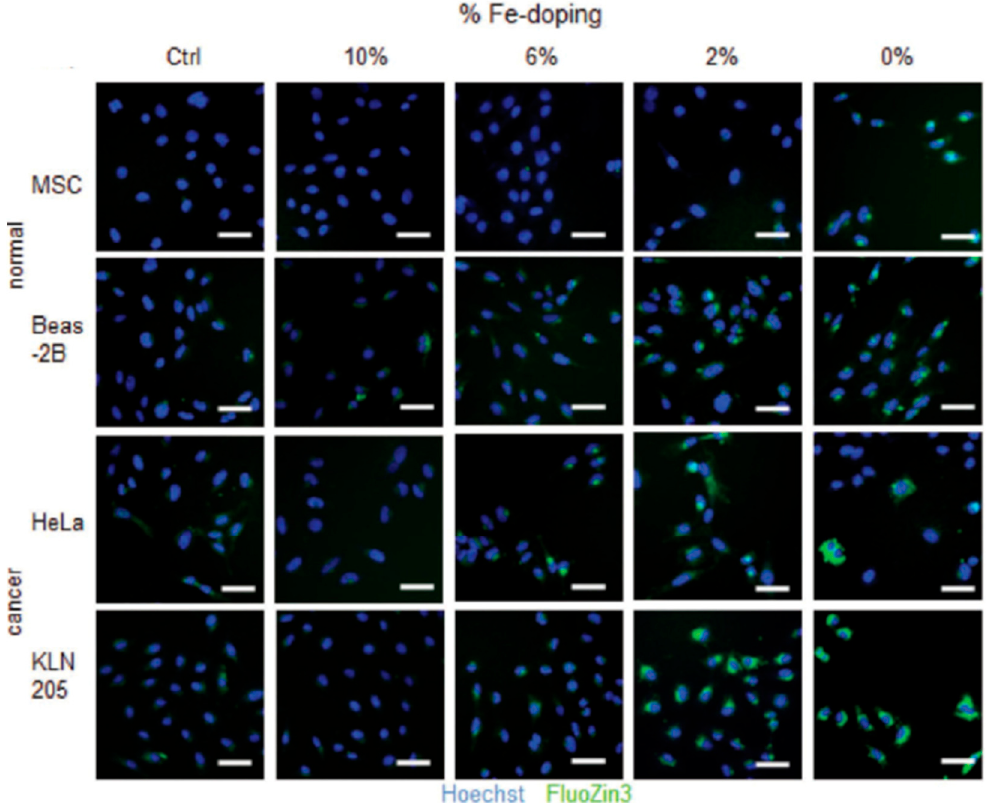
Figure 8. Fluorescence microscopy images of different cell lines exposed to differently Fe-doped ZnO nanoparticles (no nanoparticles (NPs) are present in the control samples). The green signal is related to Zn 2 + free ions (FluoZin3-AM binds to ions and have a green fluorescent emission), the blue signal is related to the presence of cell nuclei. Less doped ZnO nanoparticles lead to a higher concentration of free zinc ions. Adapted from ref.